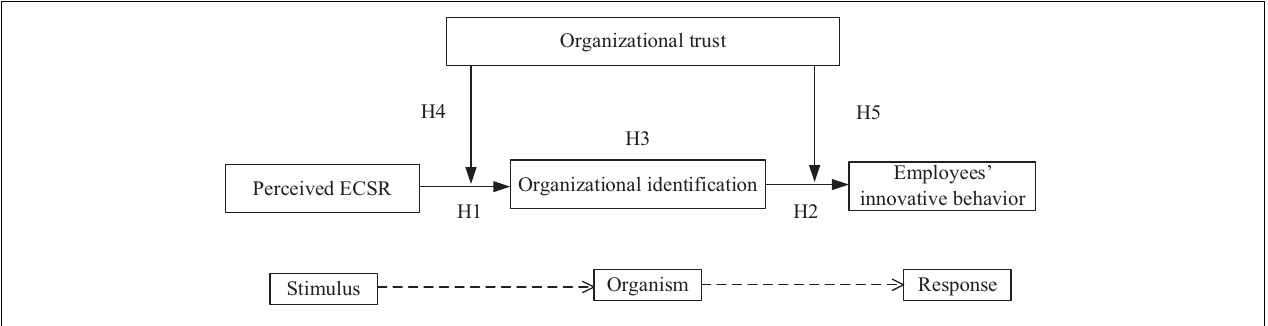
FIGURE 1 | Proposed theoretical framework and